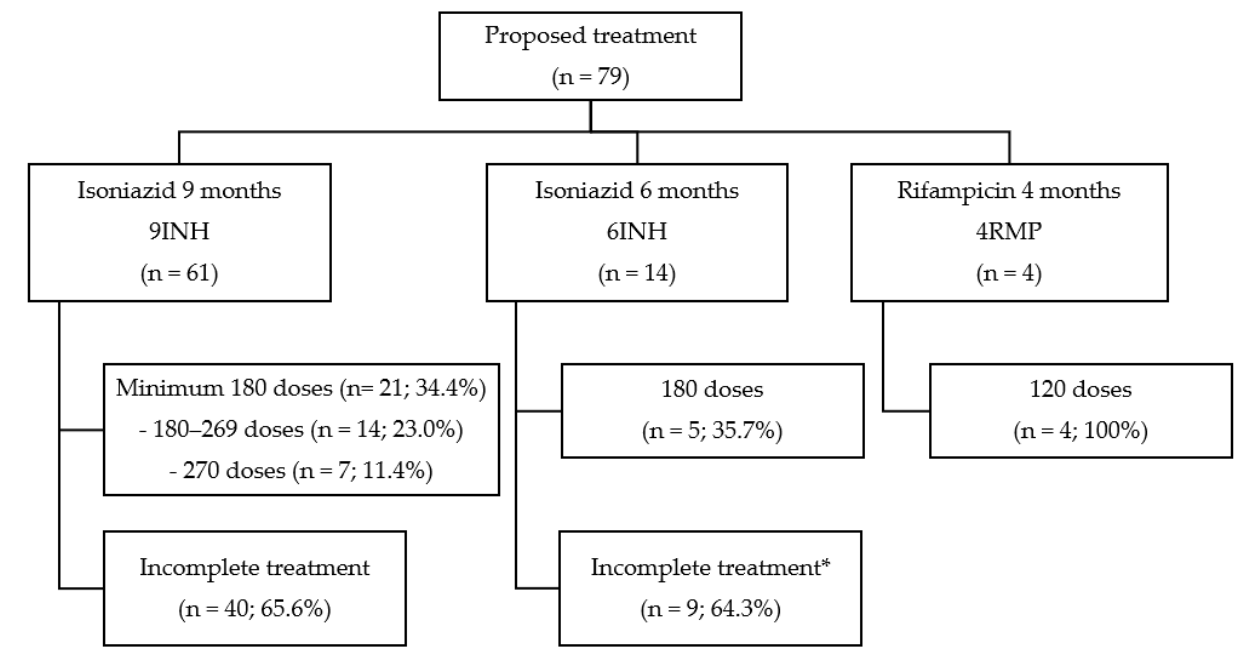
Figure 2. Flowchart of the proposed LTBT and completeness rates in the study center from 2017 to